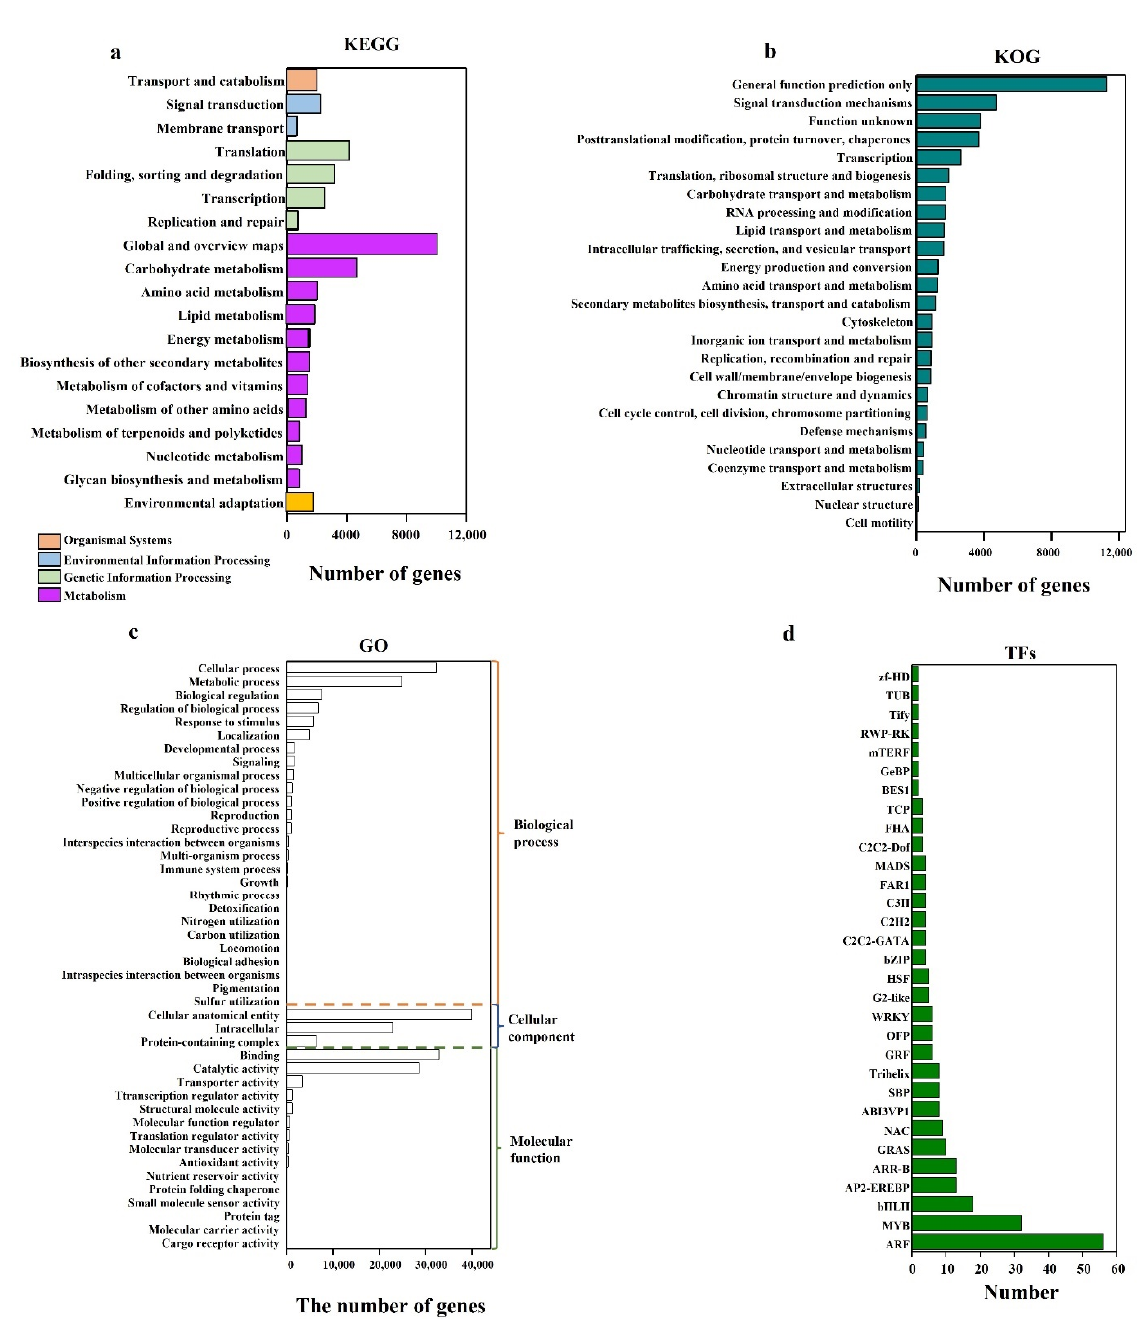
Figure 3. Functional analysis of the genes identified. ( a ) KEGG pathways distribution. ( b ) Gene Ontology (GO) assignments. ( c ) KOG functional classification. ( d ) Transcription factor (TF) categories of tree peony DEGs.